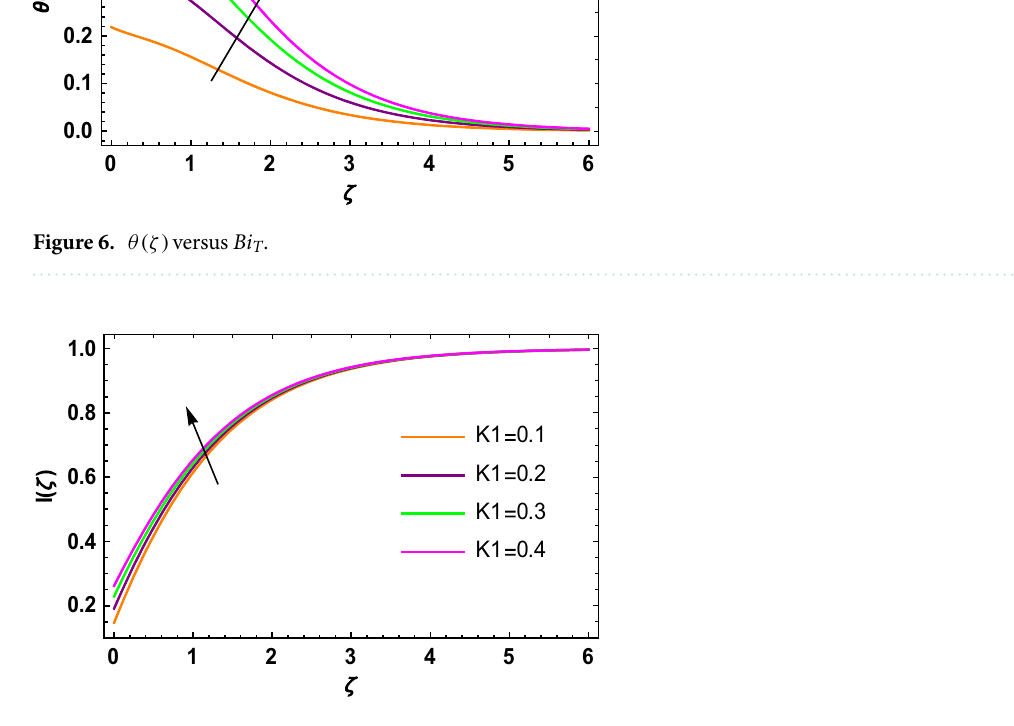
Figure 7. I (ζ) versus K 1